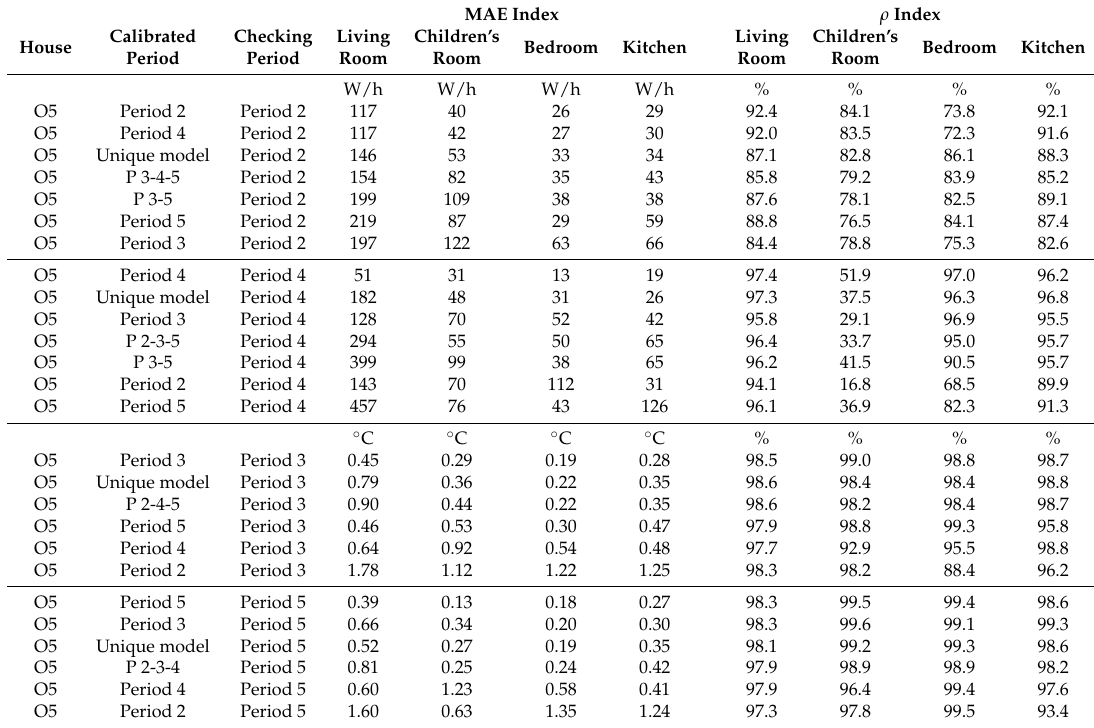
Table 5. Results of the O5 house models in the checking